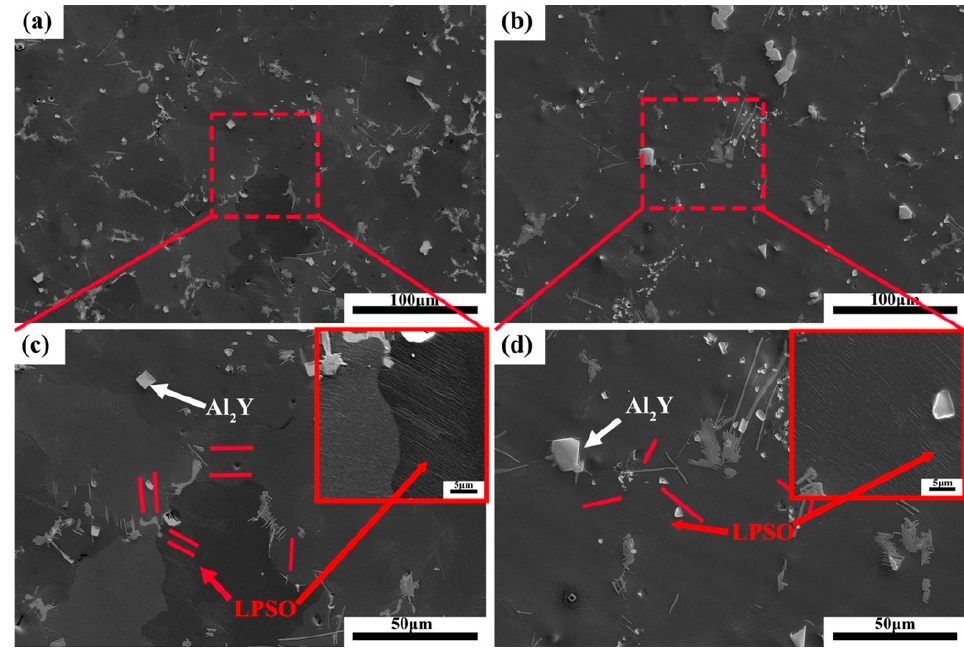
Figure 6. The SEM images of solution treatment alloys, ( a , c ) 12 h, ( b , d ) 24 h.